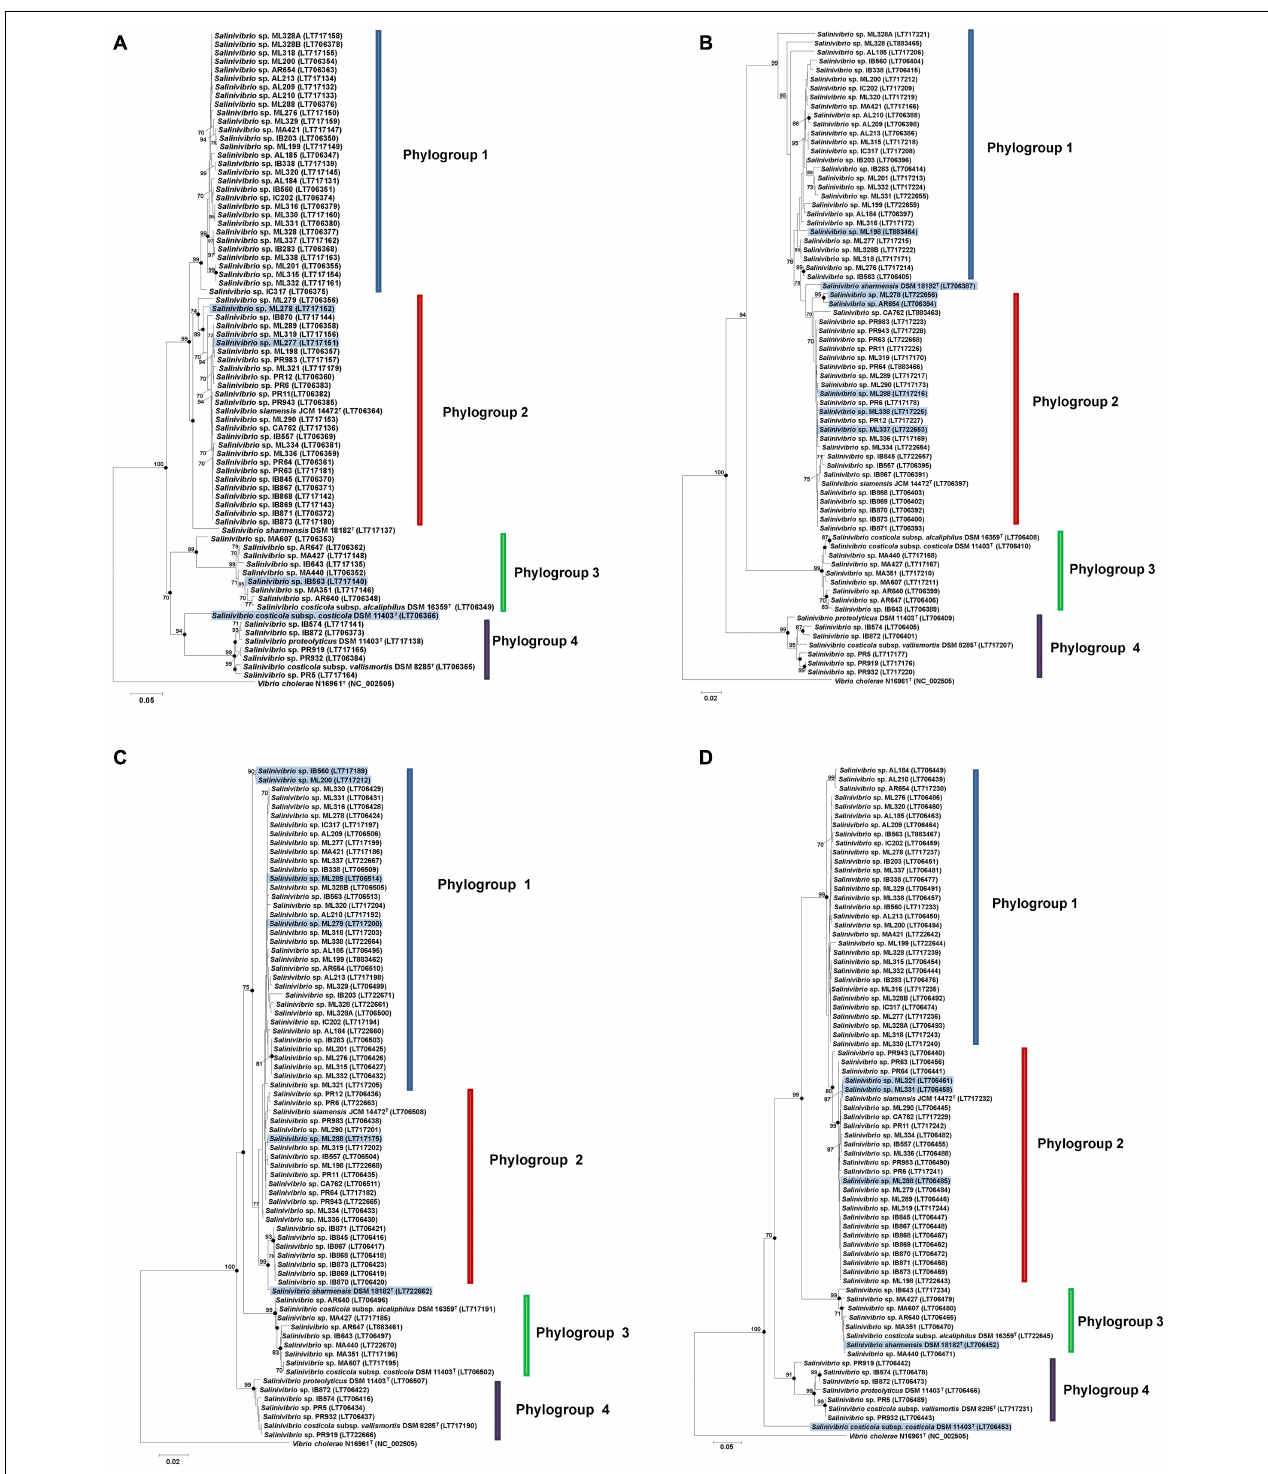
FIGURE 3 | Phylogenetic reconstructions of Salinivibrio strains based on individual analyses of the gyrB (A) , recA (B) , rpoA (C) , and rpoD (D) genes using the neighbor-joining method. Circles indicate branches that were supported by NJ, MP, and ML algorithms. The GenBank/EMBL/DDBJ accession number of each sequence is shown in parentheses. Possible events of recombination with respect to the concatenated tree are marked in blue. Only bootstrap values above 70% are shown (1000 replications) at branches points. Bars, 0.02 (B,C) and 0.05 (A,D) expected nucleotide substitutions per site. V. cholerae N16961 T was used as an